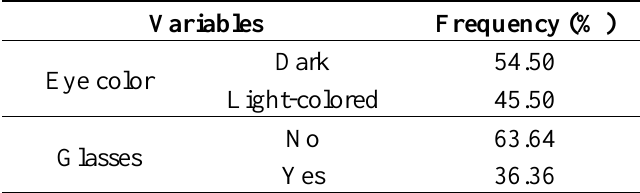
Table 6. Description of the sample ( n =